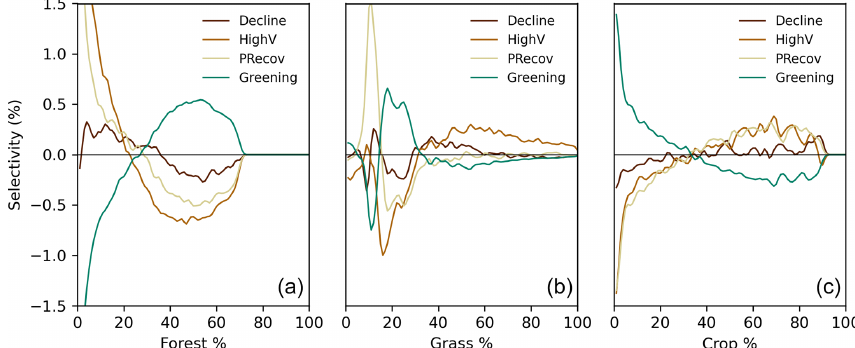
Figure B3. Selectivity of different land cover composition for each cluster (Fig. 3). Selectivity is evaluated as the difference between the probability distribution of a given land cover type (forest, a ; grassland, b ; cropland, c ) and the probability distribution of that land cover type in the selected region. If selectivity is positive, the cluster is preferentially composed by the given land cover type and the opposite for negative values. The 2018 land cover classification maps from ESA CCI-LC are used.